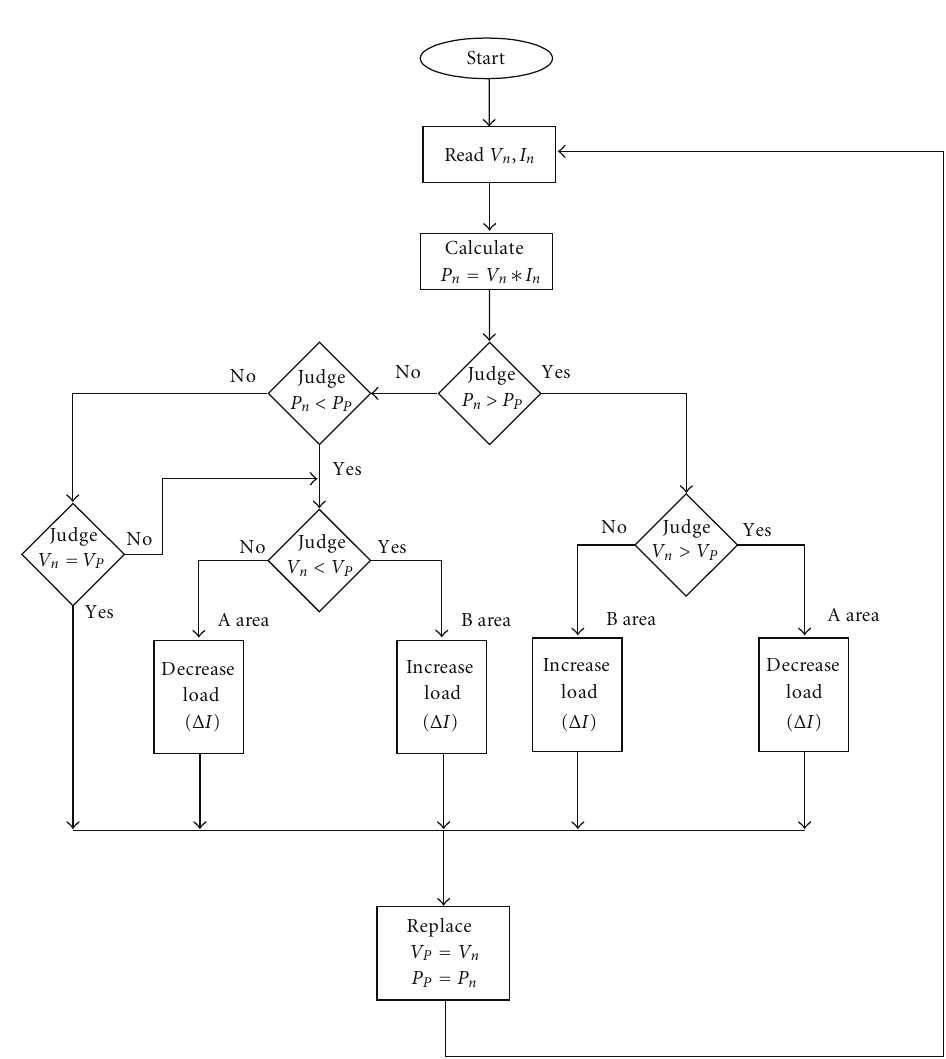
Figure 8: Flow chart of MPPT using perturbation-and-observation method for PV arrays